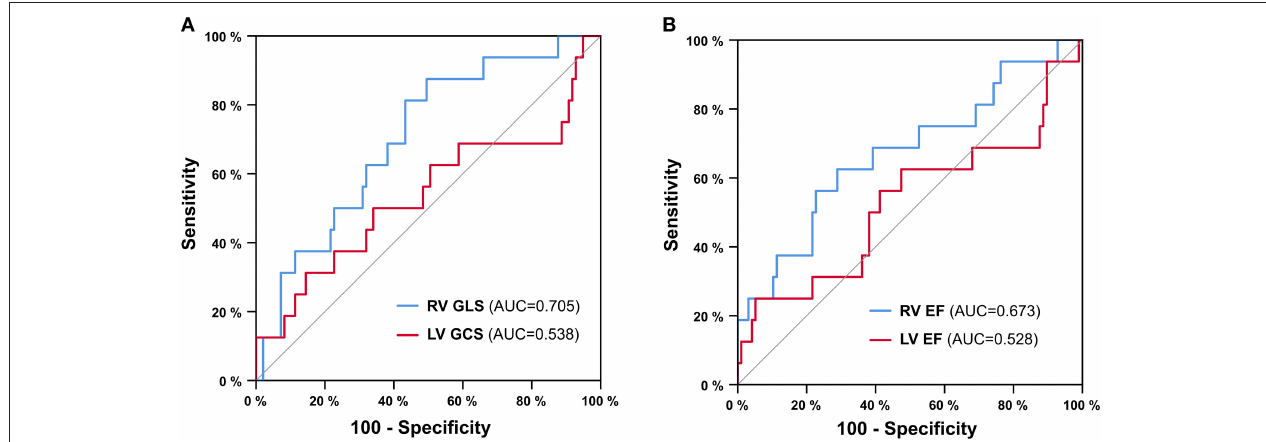
FIGURE 4 | ROC analysis for 1-year all-cause mortality. Right ventricular global longitudinal strain (RV GLS) vs. left ventricular global circumferential strain (LV GCS) (A) and right ventricular ejection fraction (RV EF) vs. left ventricular ejection fraction (LV EF) (B) . AUC = area under the curve.